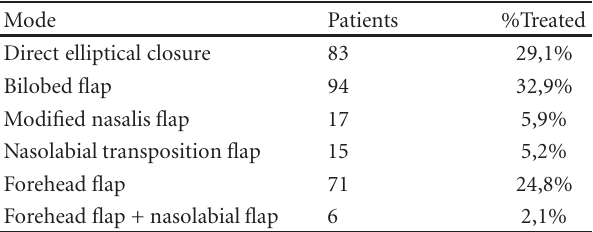
Table 1: Surgical wound management of the nose ( 286